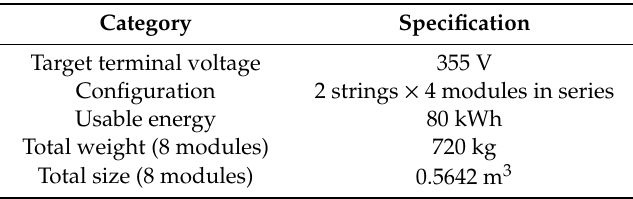
Table 6. Specifications of the selected LIB pack.